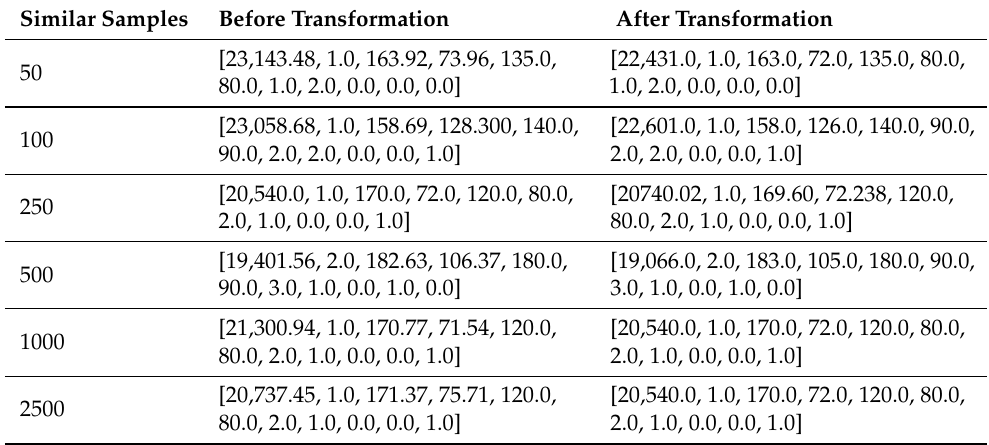
Table 12. Individual sample transformation, the experimental unit conversion